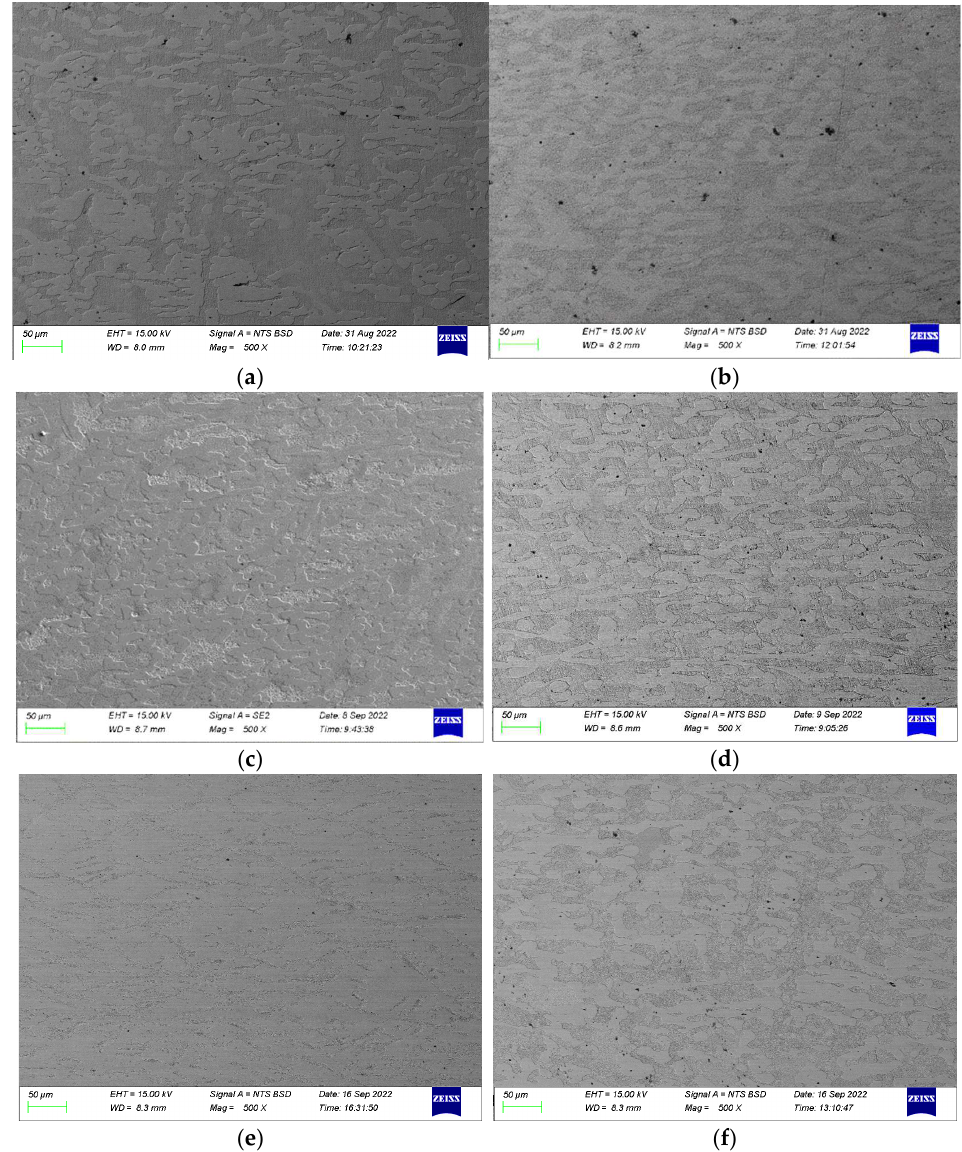
Figure 10. Scanning electron microscope images of deformed Fe-30.9Mn-4.9Al-4.5Cr-0.4C under different deformation conditions: ( a ) 800 °C at 0.1 s −1 ; ( b ) 800 °C at 5 s −1 ; ( c ) 900 °C at 0.1 s −1 ; ( d ) 900 °C at 5 s −1 ; ( e ) 1000 °C at 0.1 s −1 ; ( f ) 1000 °C at 5 s −1 .